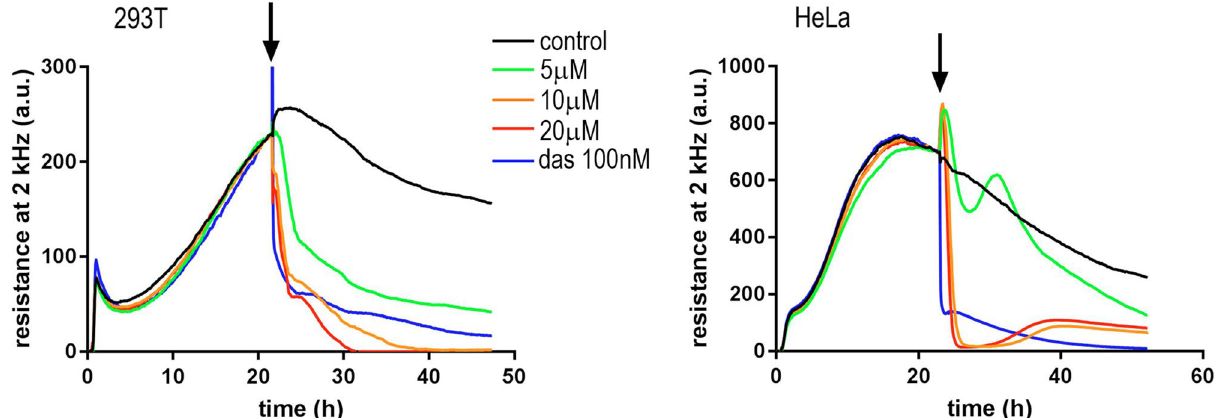
Figure 13. Decrease of the cell-surface contact area after NSC348884 addition. Resistance at 2 kHz was tracked during 293T (left) or HeLa (right) adhesion to the well bottom and after NSC348884 or dasatinib (das) addition. Times of the drug addition are marked by arrows. The curves represent mean values of triplicate/duplicate wells for NSC348884/das,